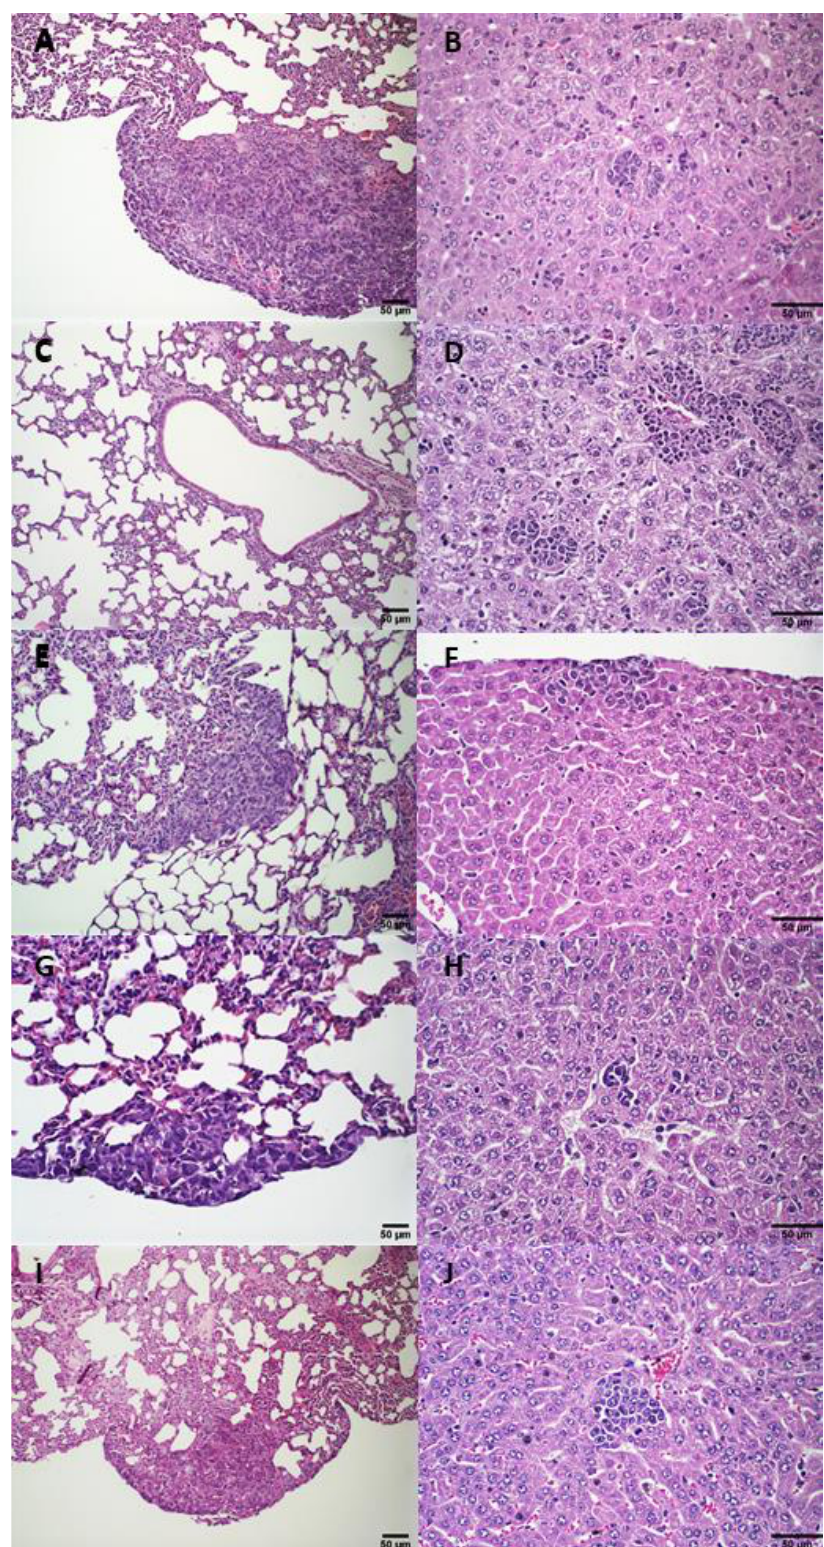
Figure A8. Histological sections of metastatic foci in lungs and liver of female Balb/c mice bearing 4T1 breast tumors treated with HBS ( A , B ), ExoSpHL ( C , D ), and DOX at a cumulative dose of 25 mg/kg ( E , F ), SpHL-DOX at a cumulative dose of 25 mg/kg ( G , H ), and ExoSpHL-DOX at a cumulative dose of 25 mg/kg ( I , J ).